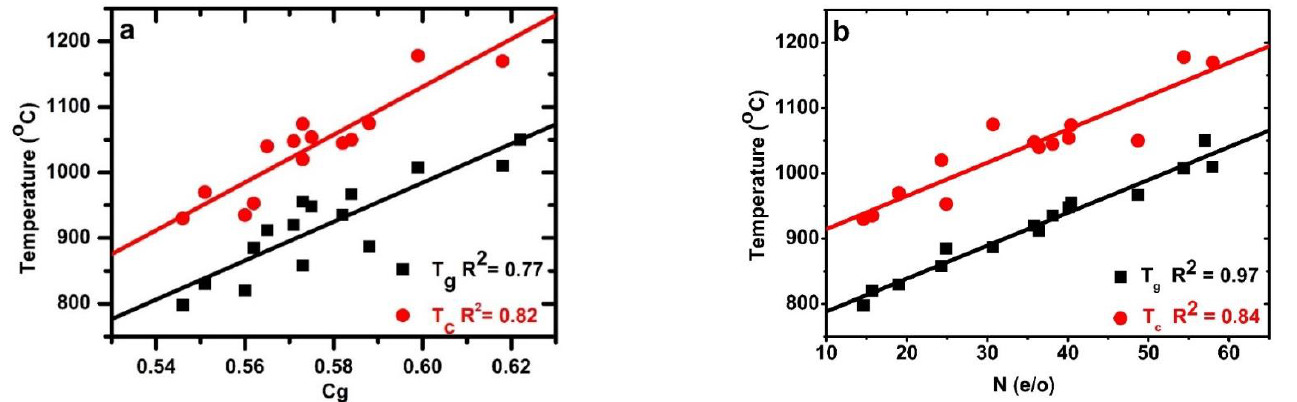
Figure 3. ( a ) Glass transition and crystallization temperatures as a function of glass atomic packing density ( b ) glass transition and crystallization temperatures as a function of nitrogen content.